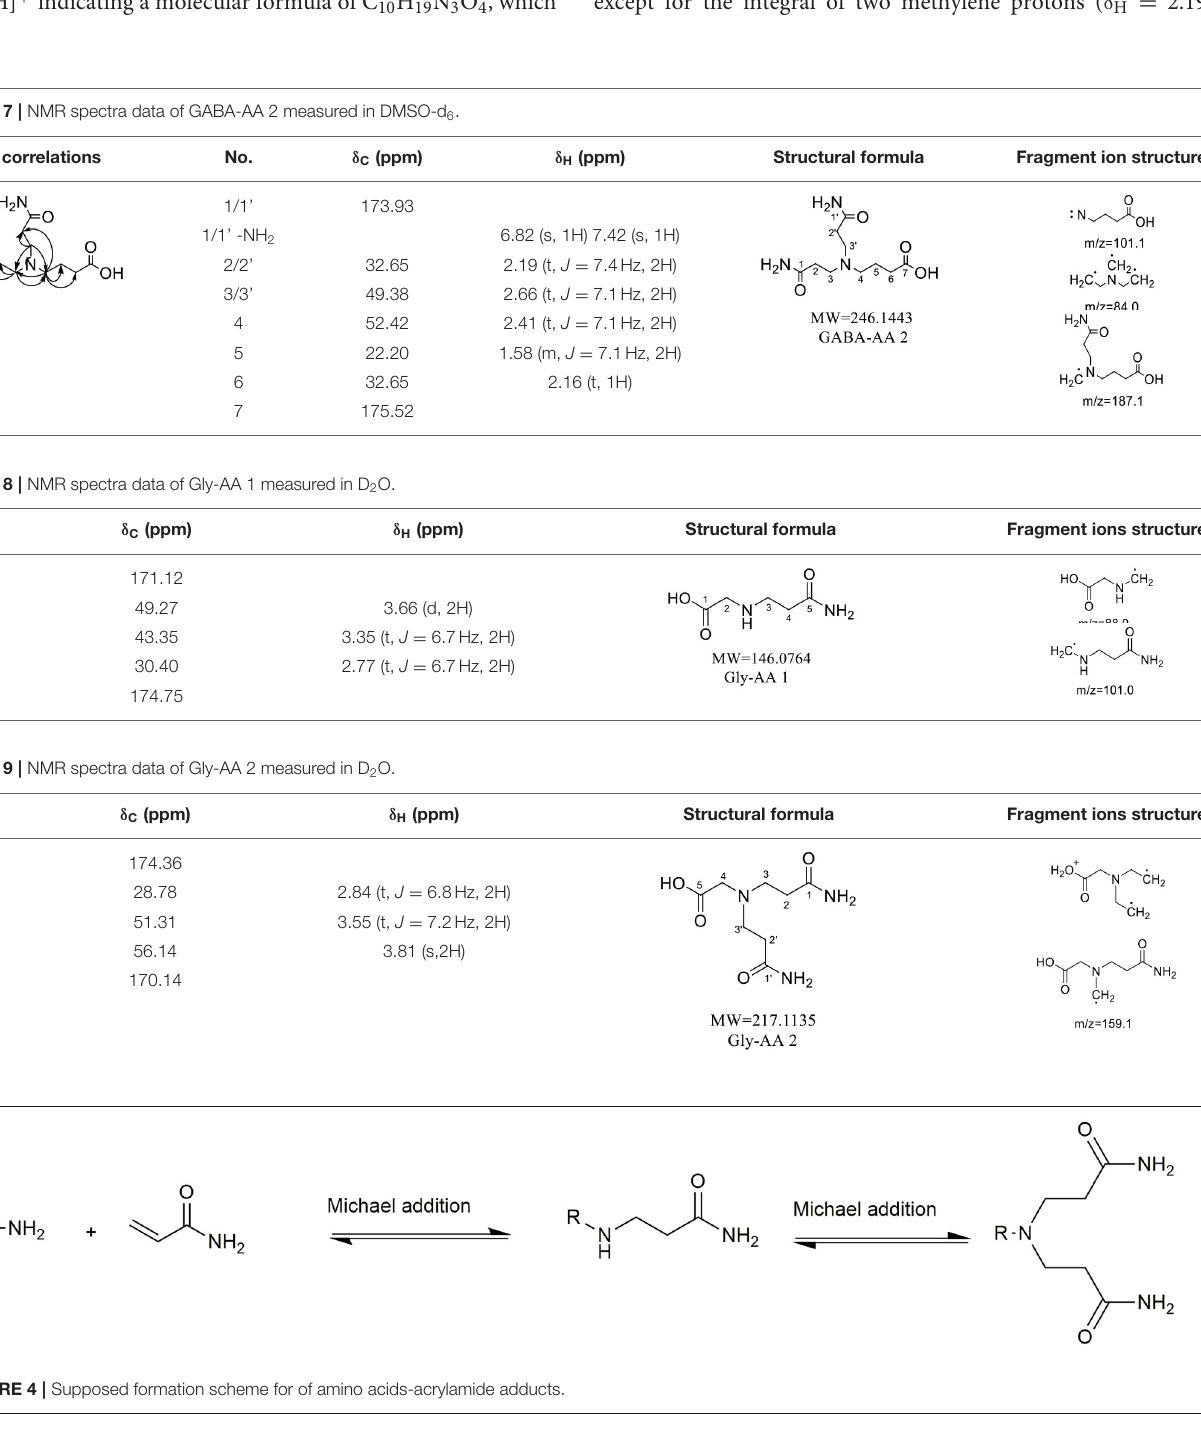
Frontiers in Nutrition |